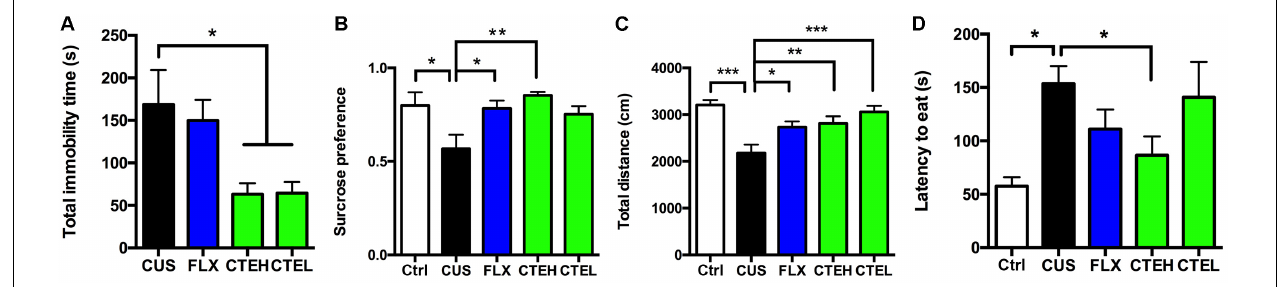
FIGURE 1 | Effects of CTE on behavioral test of CUS rats: (A) forced swimming test, (B) sucrose preference test, (C) open-field test, and (D) novelty-suppressed feeding test in CUS rats. Ctrl, control; CUS, chronic unpredictable stress; FLX, fluoxetine; CTEH, C. tubulosa extract high dose; CTEL, C. tubulosa extract low dose.